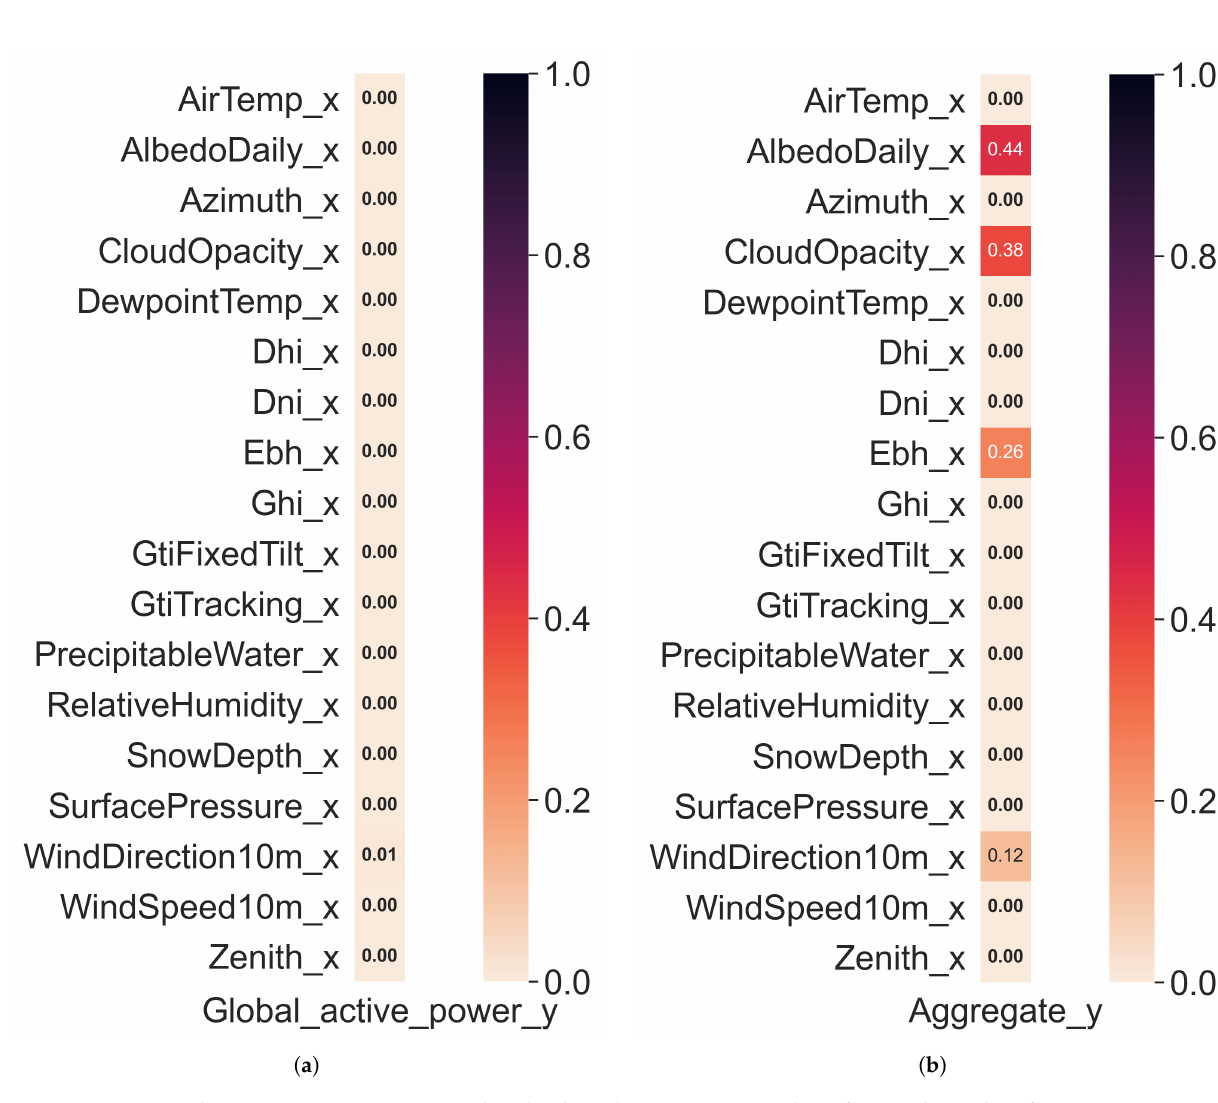
Figure 4. Trimmed Granger Causation matrix that displays the Granger Causality of our independent features against our target variable for the UCID and REFIT datasets. ( a ) UCID data set. ( b ) REFIT data set.